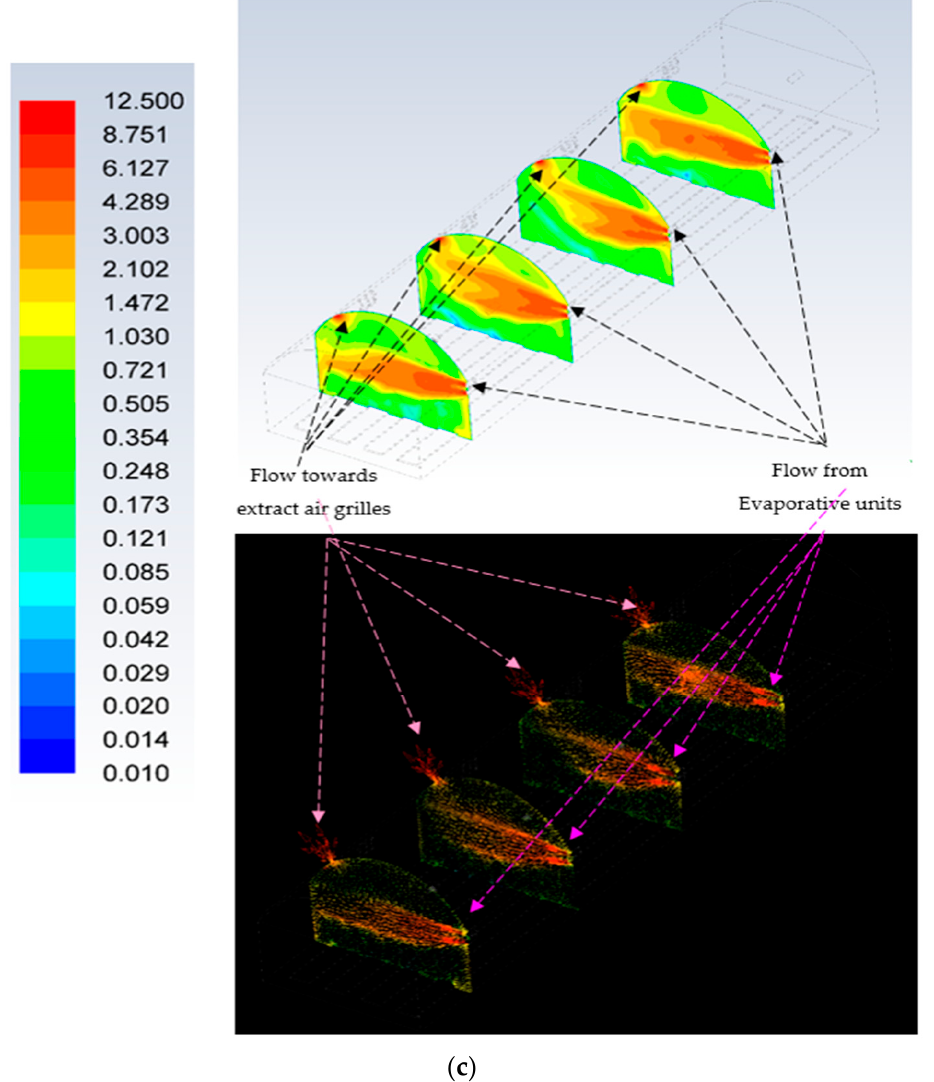
Figure 7. ( a ) Contour plot of air velocity (in m/s) at occupancy level 1, i.e., at a height of z = 1 m from floor level. ( b ) Contour plot of velocity (in m/s) at a height of 1.7 m (XY Plane). ( c ) Contour and vector plots of the air velocity (in m/s) on the XY plane along the length of the greenhouse at various evaporative cooler locations